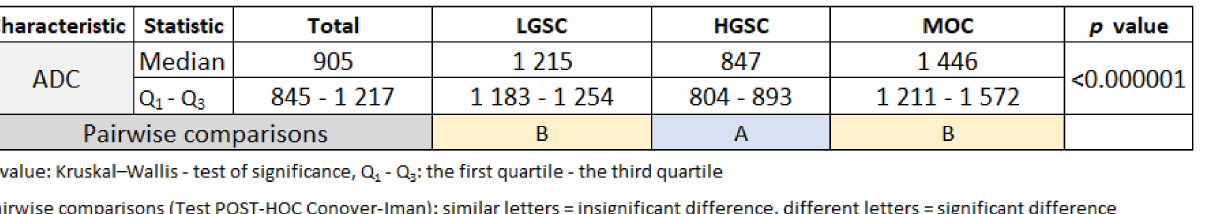
Figure 1. Multiple dot graphs for inter-observer agreement for ADC parameter performed by the two observers.